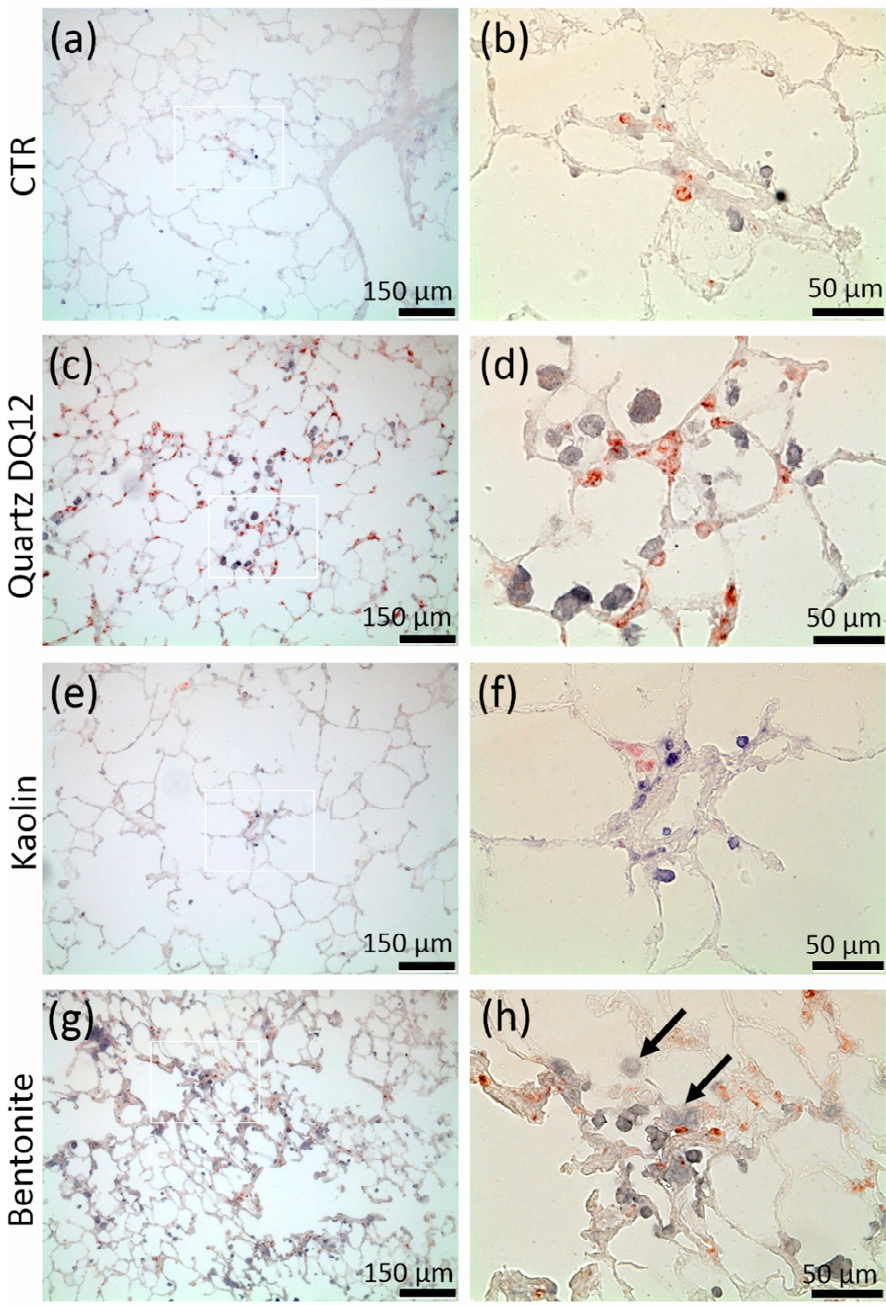
Figure 6. Distribution of alveolar macrophages (AM) and pro-surfactant protein C positive type-2 epithelial cells (AEC-II) in rat lungs treated with kaolin, bentonite, or quartz DQ12. Animals were intratracheally instilled with vehicle (CTR; a , b ), or 1.2 mg of either quartz DQ12 ( c , d ), kaolin ( e , f ), or bentonite ( g , h ) and sacrificed after 21 days (a,h). Alveolar macrophages (AM) and AEC-II were indirectly stained with antibodies against CD68 (blue) and anti-pro-surfactant protein c antibodies (red). Figure parts b, d, f, and h represent the white boxes in a, c, e, and g. Assemblies of AM and increased expression of pro-surfactant protein c are evident in quartz DQ12-treated (c,d) and bentonite-treated lungs (g,h). Hypertrophic epithelia are seen in bentonite-treated (g), but not in quartz DQ12-treated lungs.